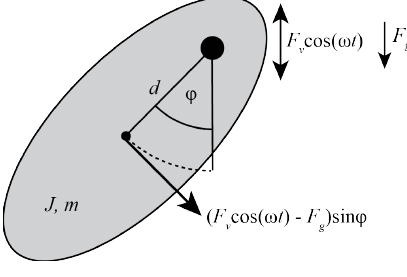
Figure 2. Physical pendulum described by its mass m , moment of inertia J and center of mass d .